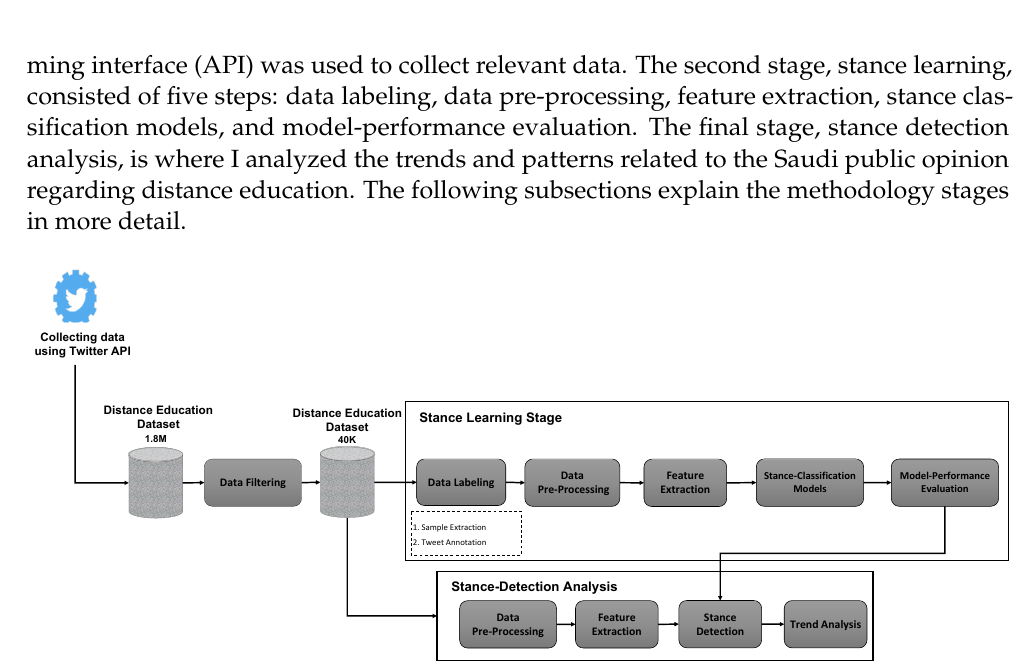
Figure 1. The adaptive Stance Analysis Approach including three main